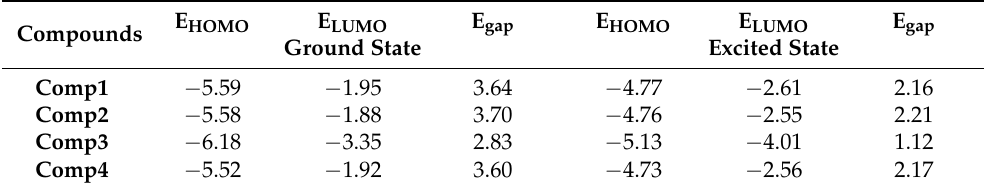
Table 1. The HOMO/LUMO energies (E HOMO /E LUMO ) and energy gaps (E gap ) of benzothiazoles at